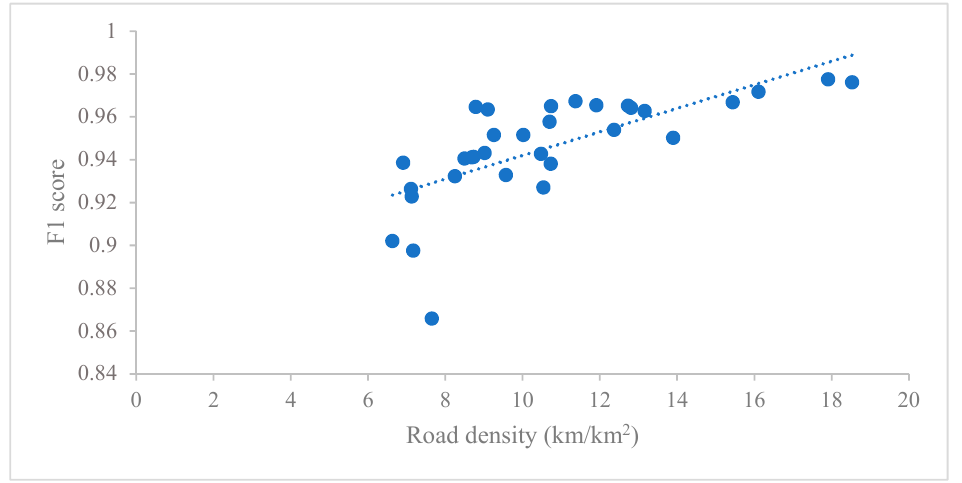
Figure 14. Relationship between road densities and F1 scores. The F1 scores correspond to the evaluation of the 32 catchment areas generated by our framework under the cut-off distance of 1.2 km.